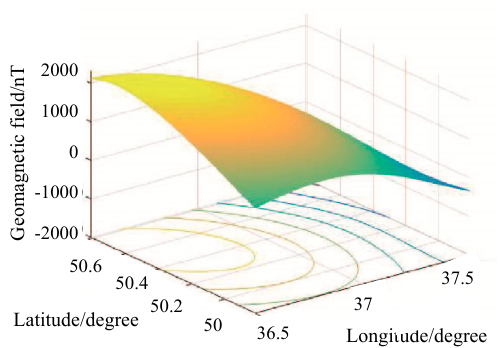
Figure 7. The geomagnetic field of a mission area.